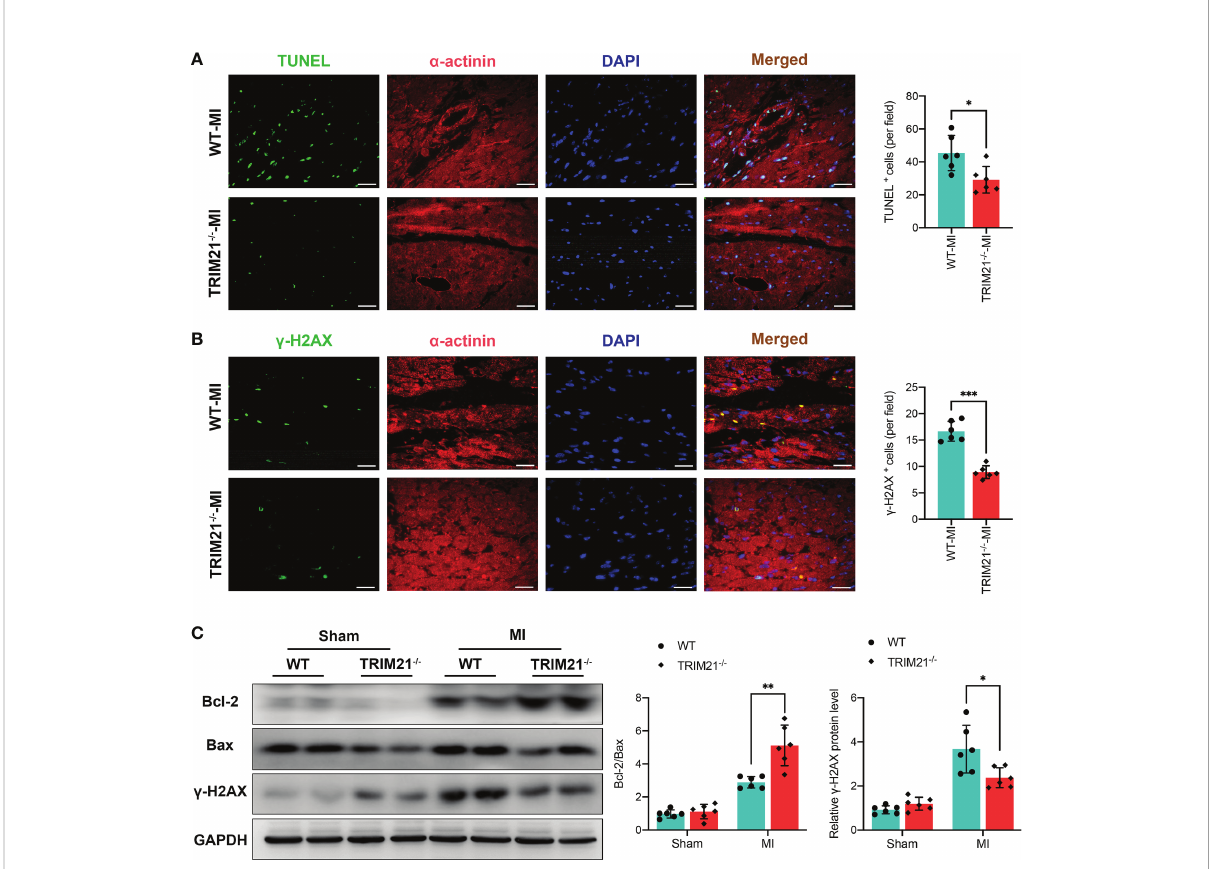
FIGURE 3 TRIM21 de fi ciency decreased MI-induced apoptosis and DNA damage. (A) Immuno fl uorescence staining and positive cell-count results of TUNEL in the heart tissues. (B) Representative double- fl uorescent immunostaining images of g -H2AX and a -actinin. The positive g -H2AX ( g - H2AX + ) cell areas were quanti fi ed (right). (C) Bcl-2, Bax, and g -H2AX protein expressions at day 3 post-MI in the infarct zone isolated from WT and TRIM21 -/- mice. For A-C, data are representative of 3 independent experiments. n = 2 mice/group. *P<0.05, **P<0.01, and